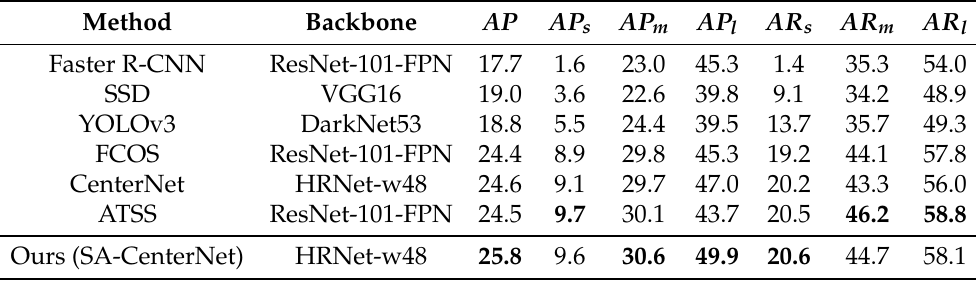
Table 2. Experimental results from different models with the BDD100K dataset. All competing algorithms are implemented with MMDetection, and the default settings are used for the parameters.